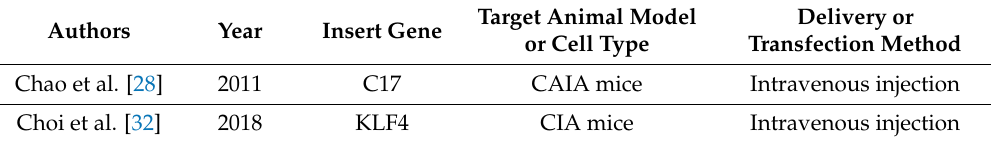
Target Animal Model Delivery or or Cell Type Transfection Method